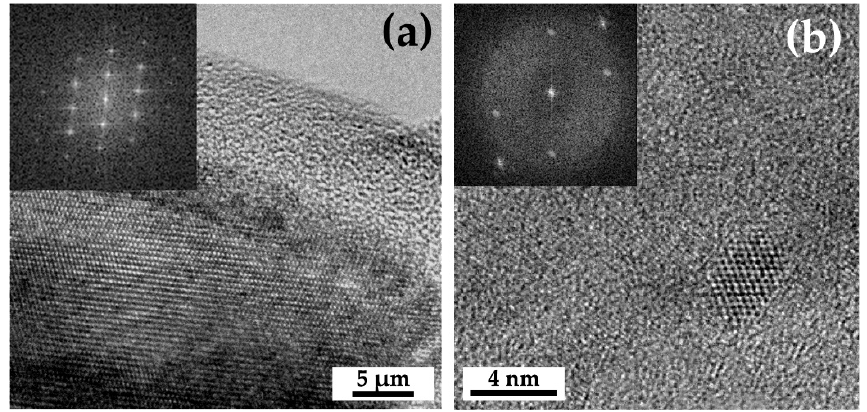
Figure 13. HREM micrographs of the ODS-L steel annealed at 1273 K after HCR: ( a ) Ti-rich precipitate indexed as Ti 2 CrO 7 on the zone axis <010>; ( b ) Y-Ti-O nanoparticle 4 nm in size indexed as Y 2 TiO 5 on the zone axis [021].